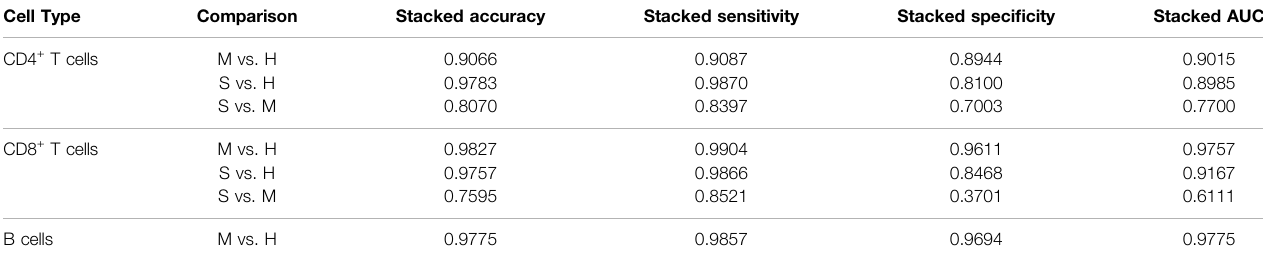
TABLE 1 | Results of the prediction of the selected MLP models. H, M, and S indicate the healthy, the mild and the severe COVID-19 groups, respectively. Cell